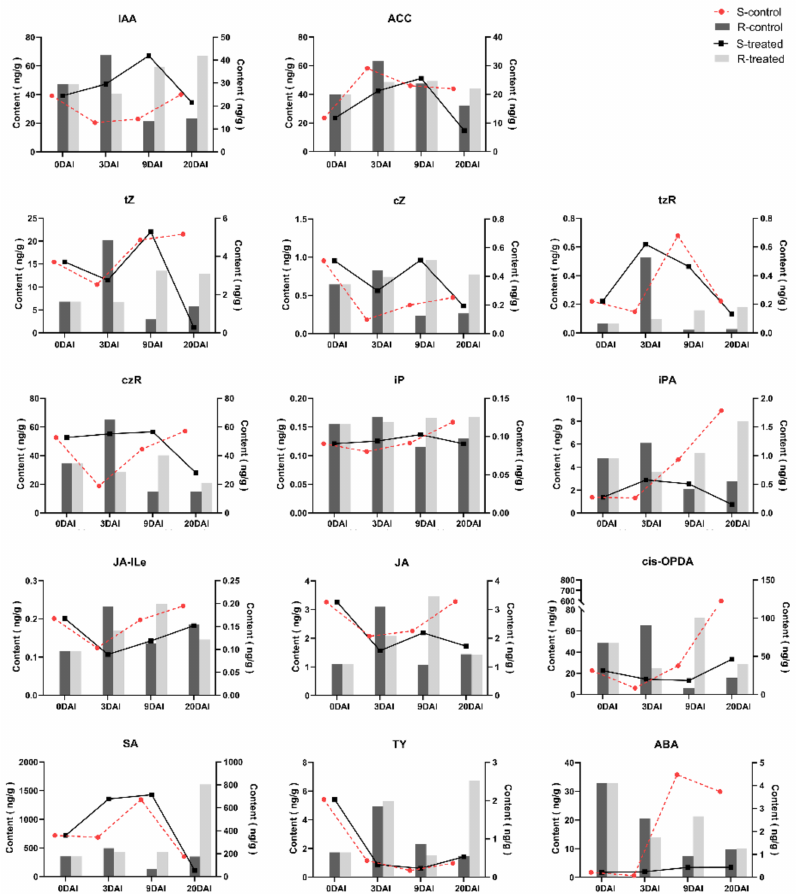
Figure 5. The contents of different phytohormones in the roots of R- and S-lines at four time points after inoculation with P. brassicae at 0, 3, 9, and 20 DAI. The content of phytohormones in the S- and the R-lines are presented in the left and right Y axis,